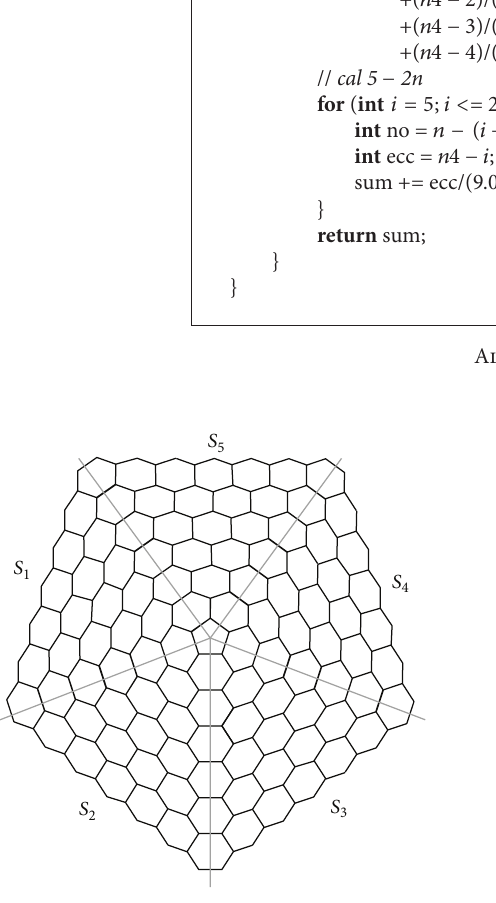
Figure 2: The partitions of pentagonal carbon nanocone PCN 5 [𝑛] .